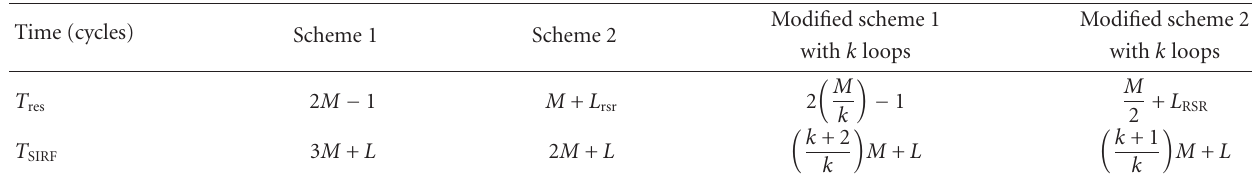
Table 2: Timing of SIRF using the di ff erent proposed architectures.